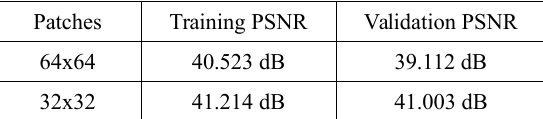
Table 1. Different patches training and validation scores of PSNR in dB